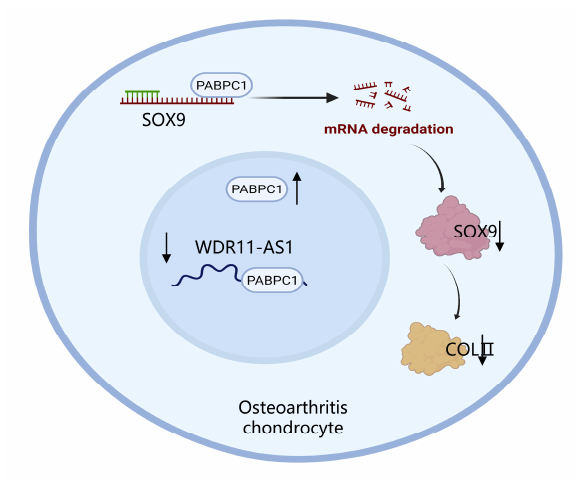
Figure 8. Schematic diagram representing the lncRNA WDR11-AS1 and PABPC1 interaction con- trolling ECM synthesis in OA chondrocytes. Upregulation of PABPC1 interferes with lncRNA WDR11-AS1 regulation and enhances SOX9 mRNA decay, thereby reducing ECM synthesis.